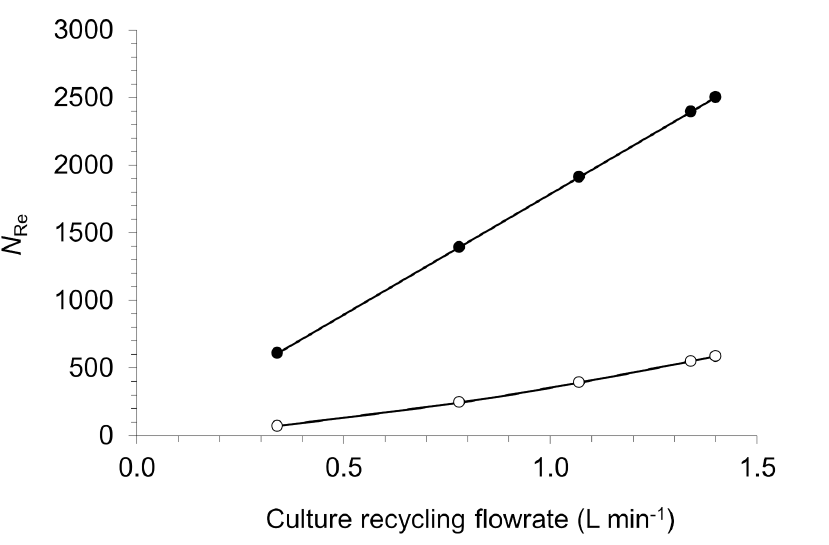
Figure 4. Reynolds number calculated for the helical photobioreactor as a function of the culture recycling flowrate at two different cell concentrations (g DW L − 1 ): (